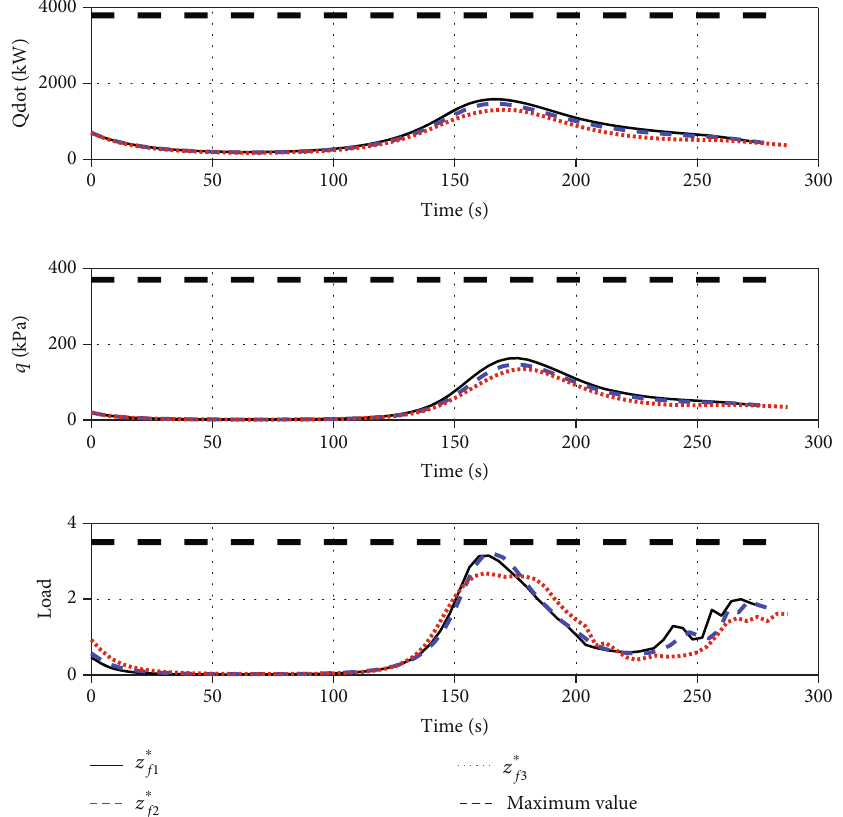
Figure 11: Comparison of path constraints.